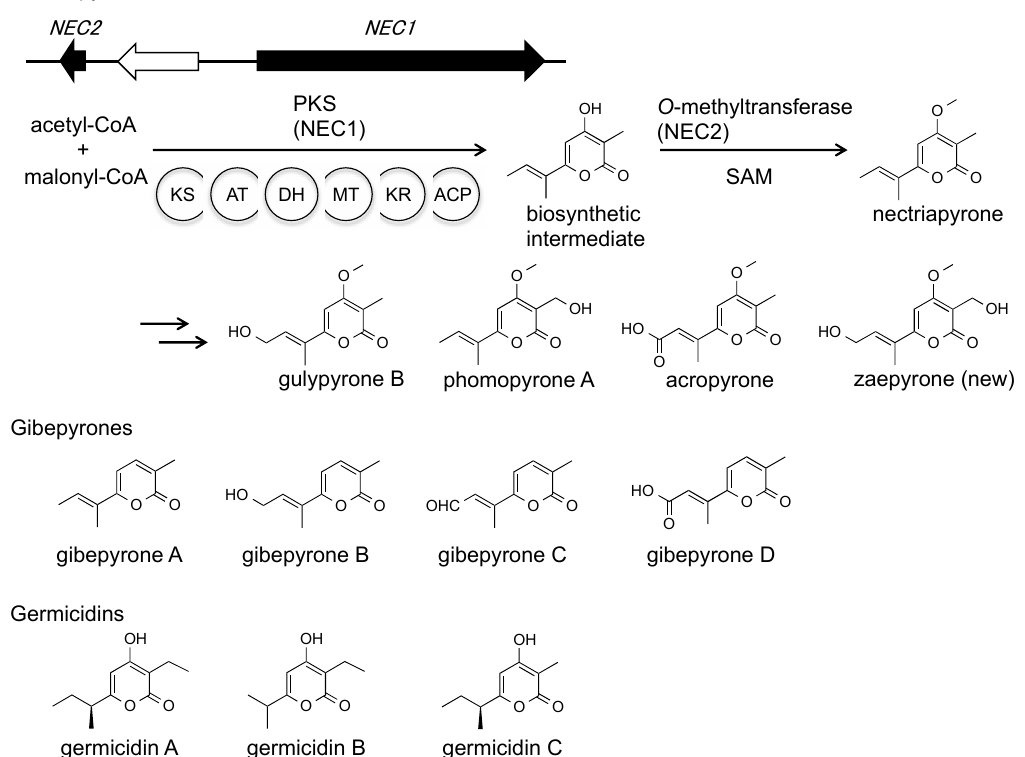
Figure 4. Nectriapyrones and related compounds.